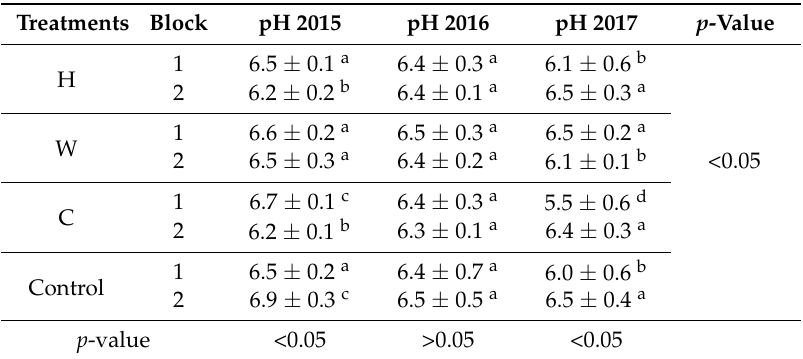
Table 10. Results of the ANOVA and Tukey test for pH (df 3, 72; average ± SD), difference tested between the soil of the harvested area, and control.